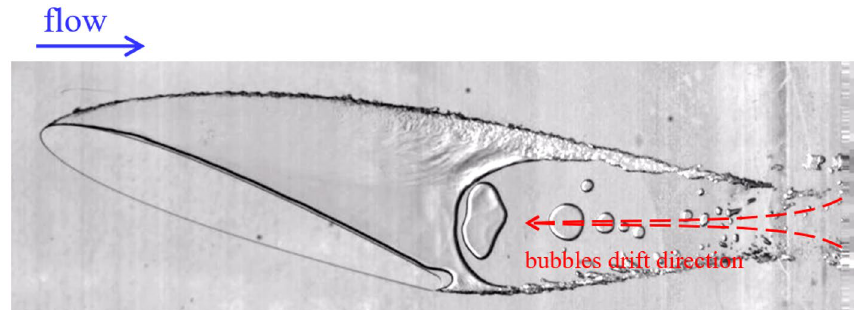
Figure 3. Supercavitating foil. A reverse motion of the water–vapor mixture phase occurred within the trailing edge of the cavity. Re = 9·10 5 . σ = 2.5 (see Supplementary